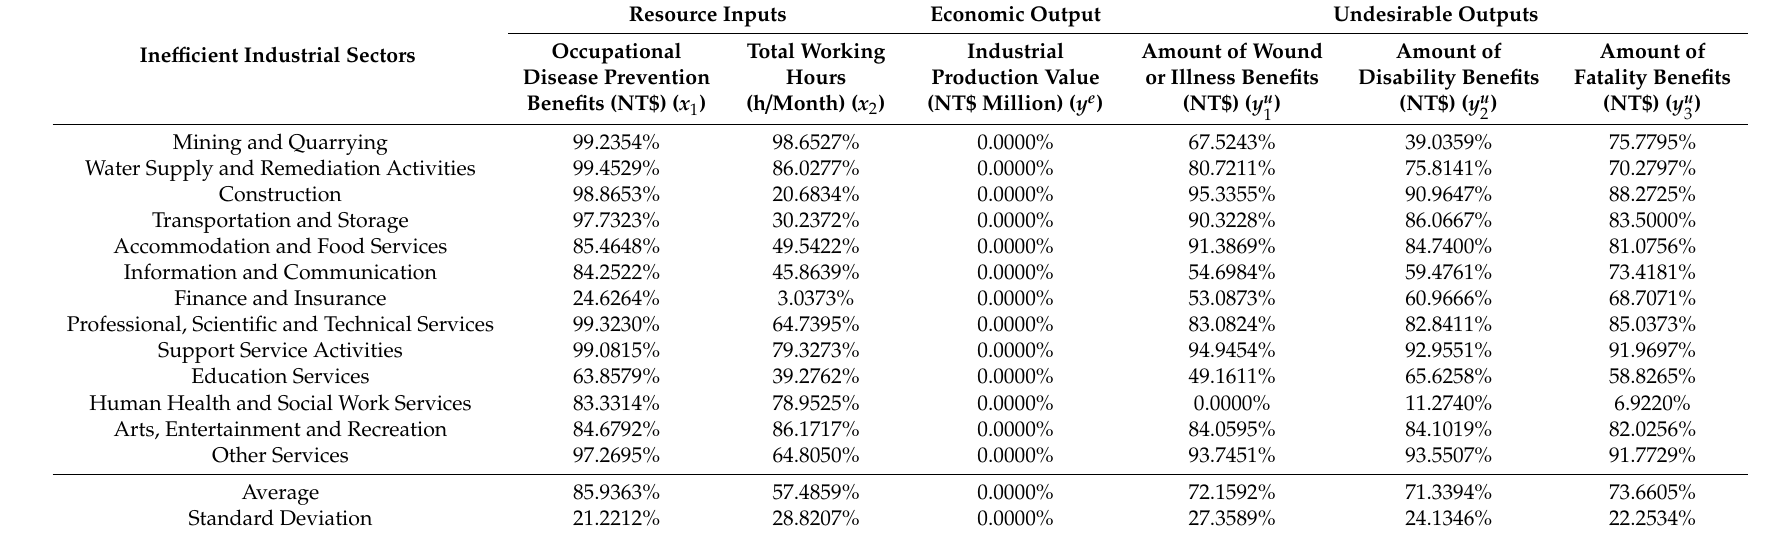
Table 4. The slack ratio index for the resource inputs, economic outputs and three socioeconomic costs of occupational